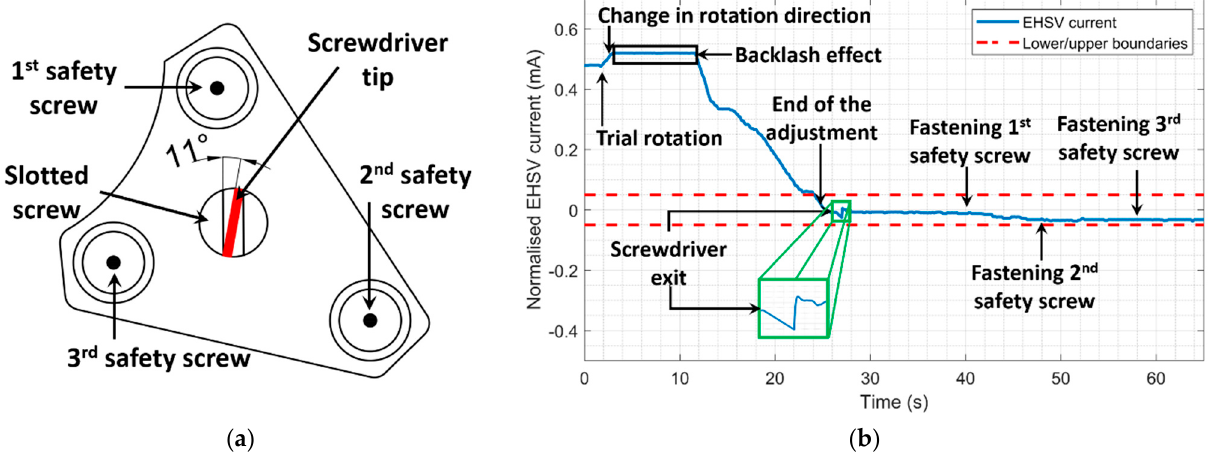
Figure 5. ( a ) Schematic representation of the backlash between the screwdriver and the slotted screw to be regulated; ( b ) Adjustment of the EHSV current and effect of the fastening of the three safety screws on the EHSV current .